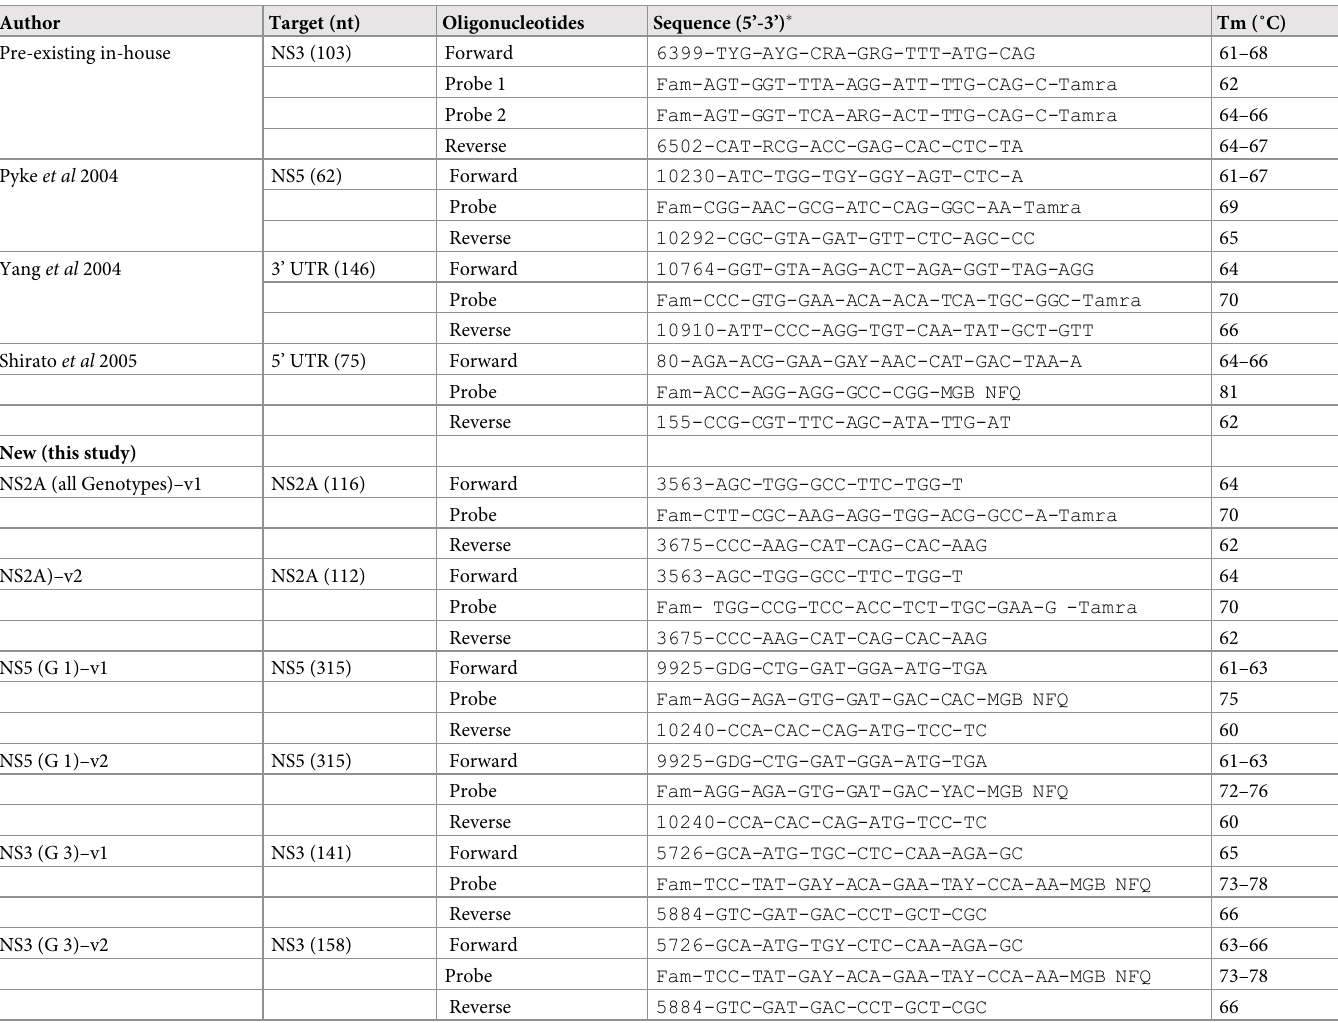
Table 4. Primers and probes evaluated during the